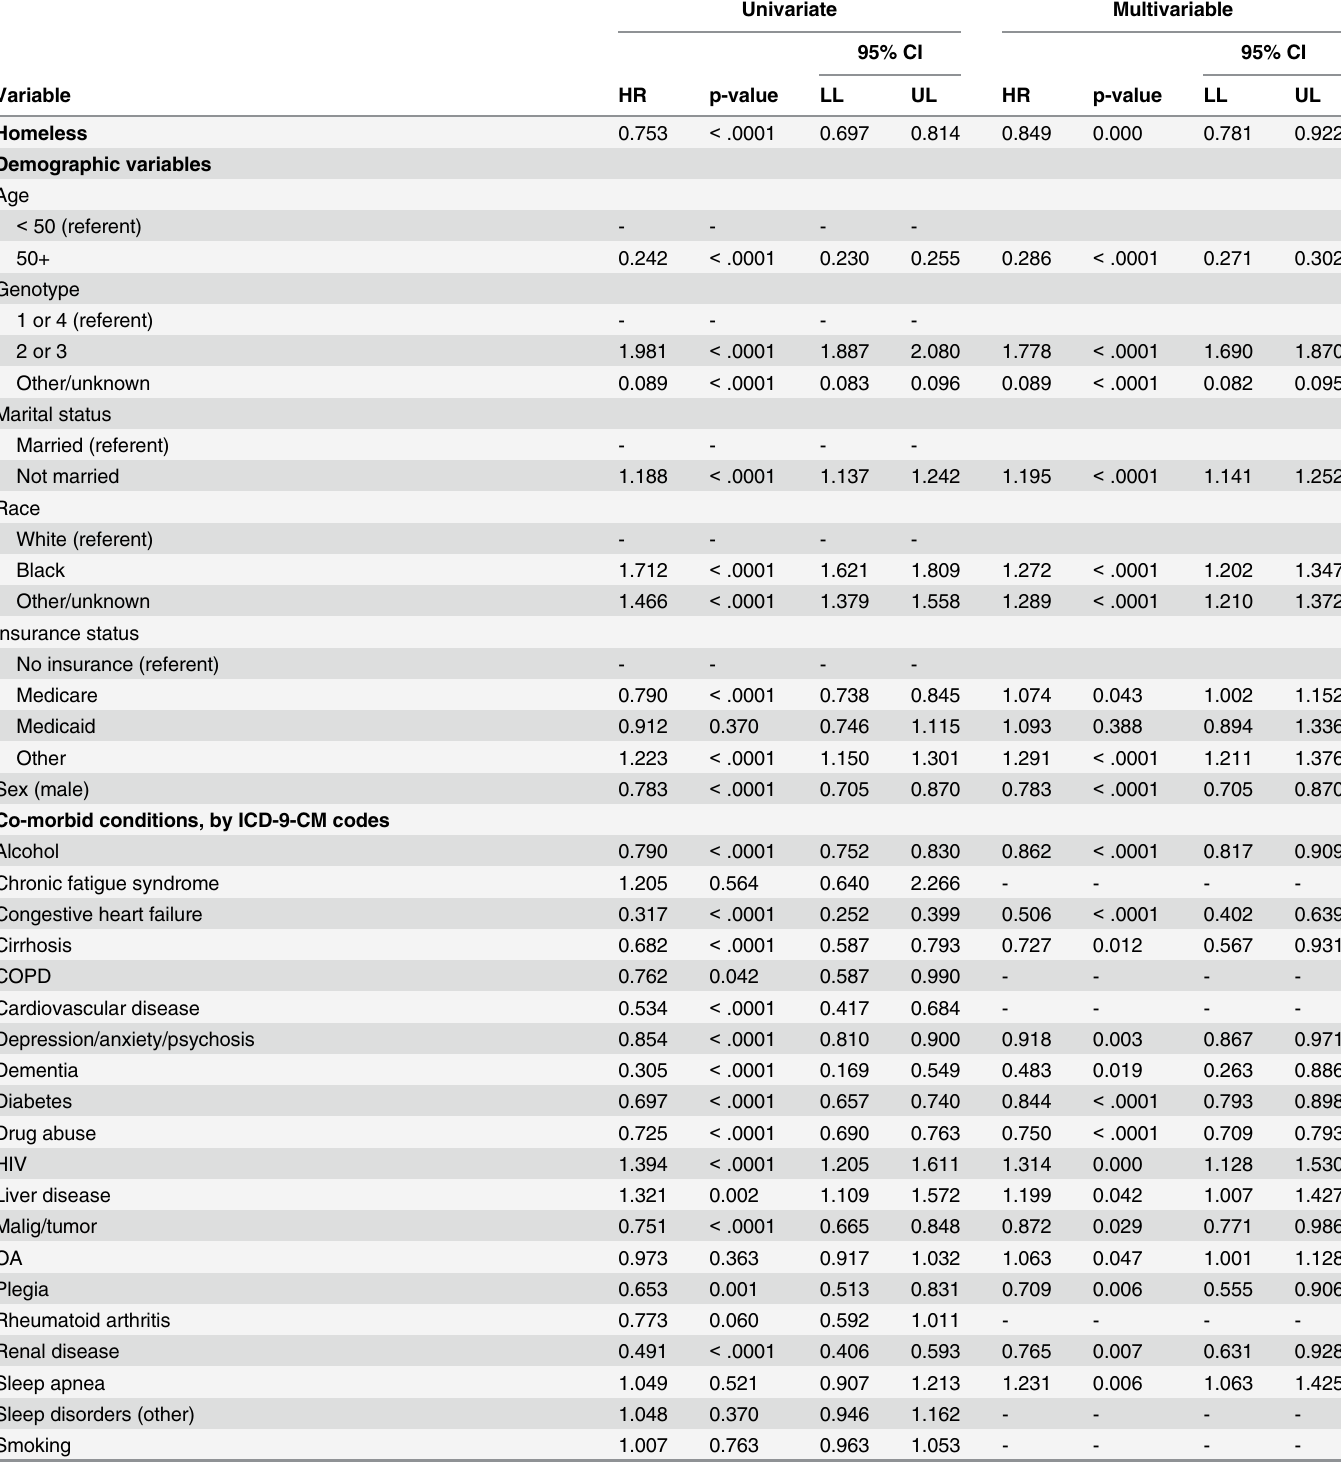
Table 2. Results of univariate and multivariable Cox Proportional Hazards regression models of initiation of HCV treatment in 101,444 U.S. Veter- ans with chronic hepatitis C (HCV) diagnosis who were treatment na ï ve for HCV, 2004 –